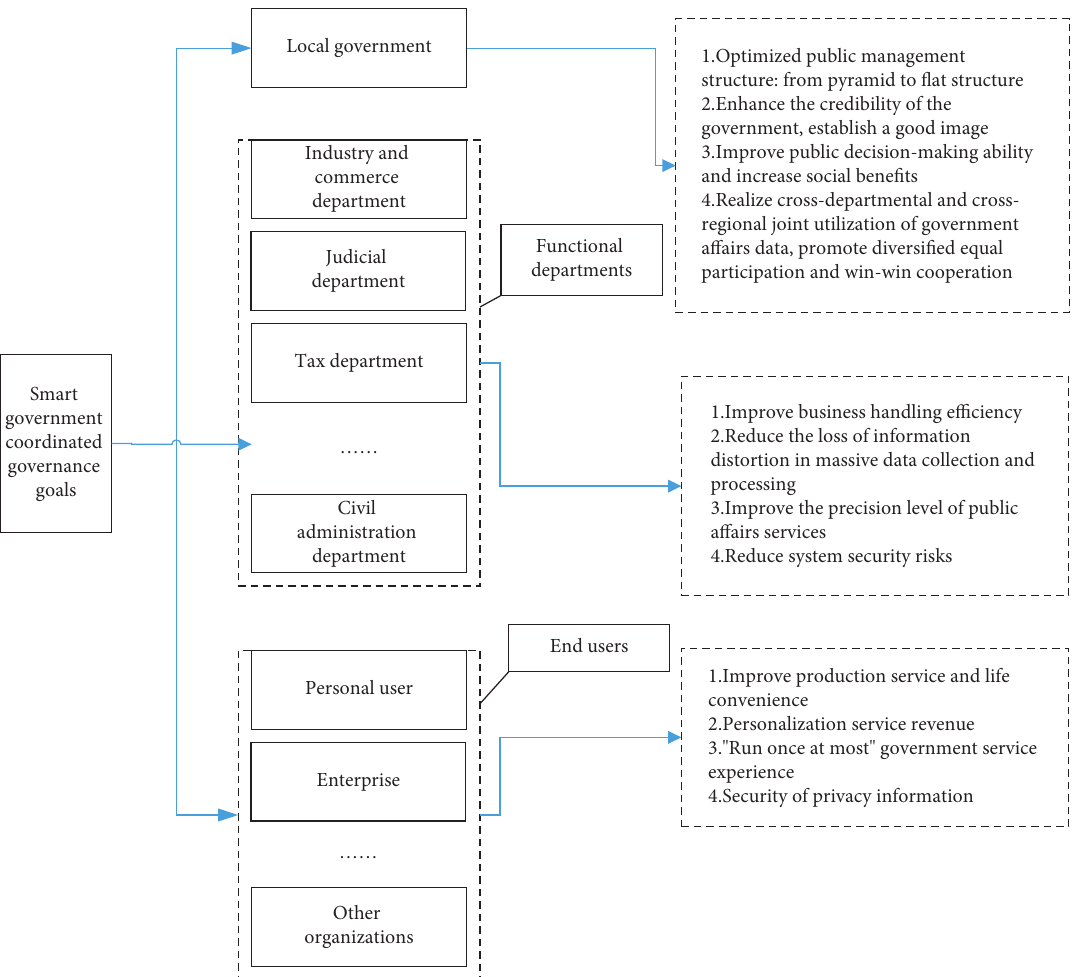
Figure 4: The goal of each stakeholder in the smart government collaborative governance model with blockchain